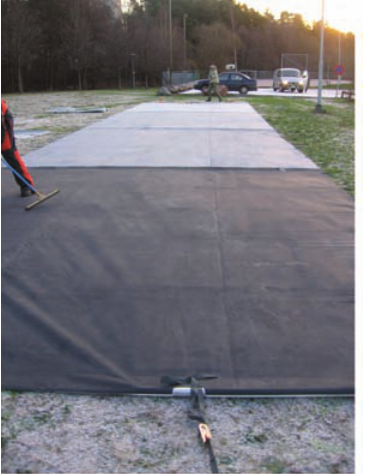
Fig. 2. Brightness targets in Espoonlahti, Dec 2006 (Kaasalainen et al .